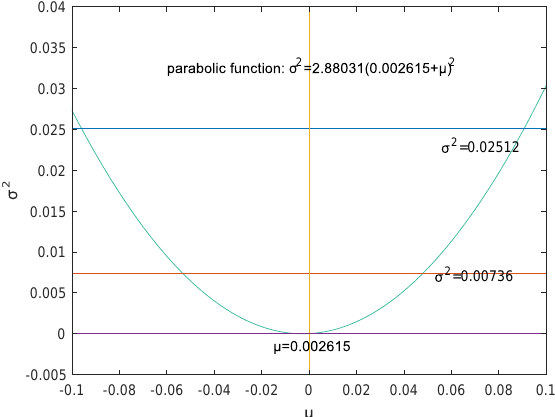
Figure 3. The joint confidence region of ( µ , σ 2 ) by ideal point method.